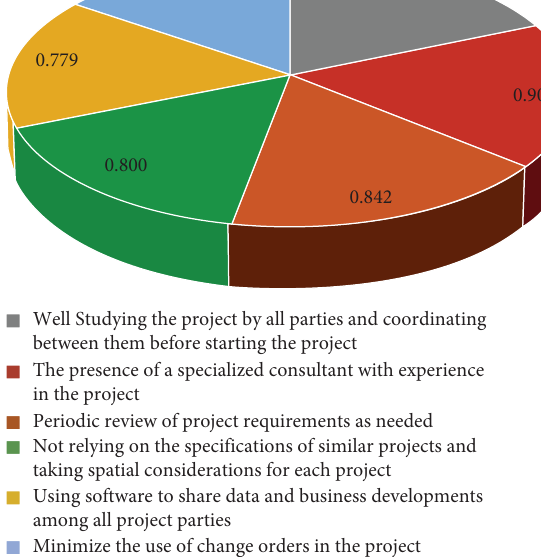
Figure 6: )e most important factors that mitigate the impacts of change orders (contractors’ responses).